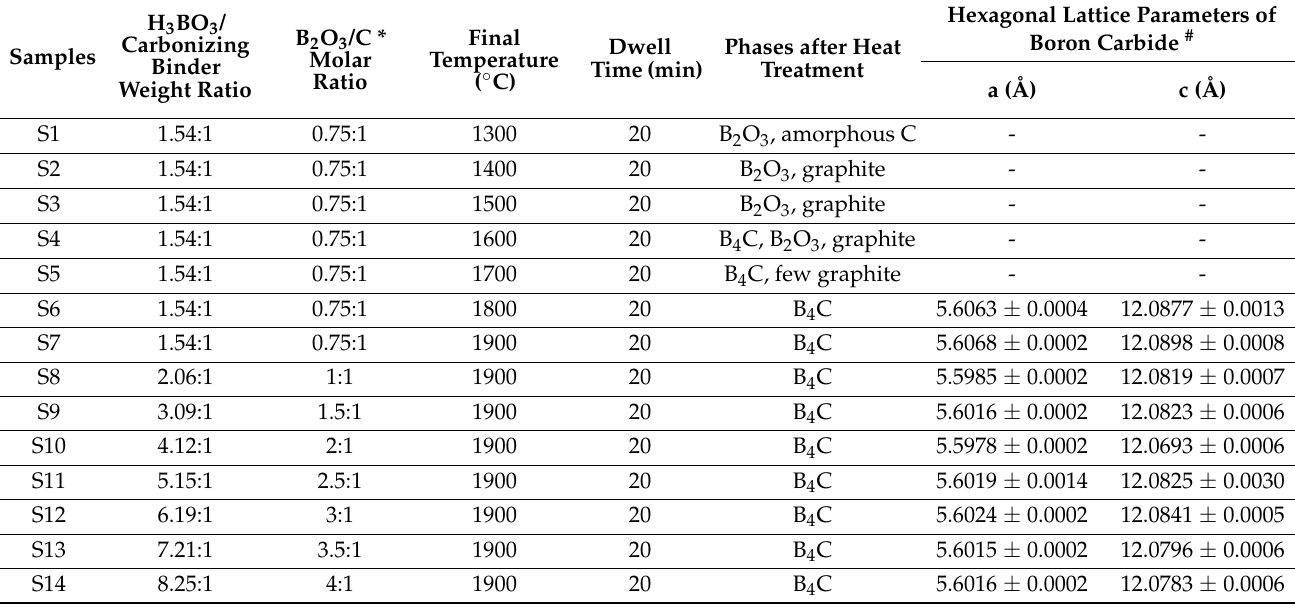
Table 1. Composition of starting powder mixtures, processing conditions, phase constitution and lattice parameters of synthesized boron carbide